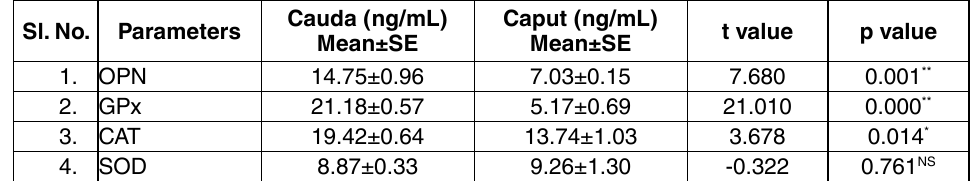
table 1. Comparison of OPN, GPx, CAT and SOD concentrations (ng/mL) in cauda and caput epididymis